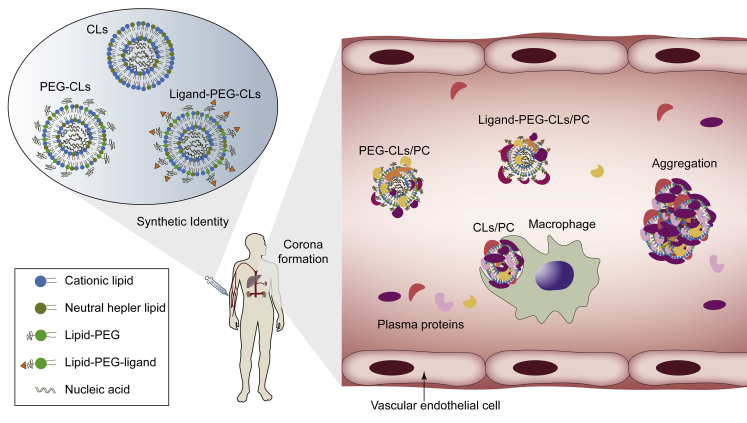
Schematic Representation of the Effects of PC on CLsThe decoration of PC obscures the surface charge and targeting ligands of CLs, increases their size, and leads to aggregation and off-target. Most of them are quickly cleared by macrophages. PEG-CLs reduce the adsorption of proteins to some extent.